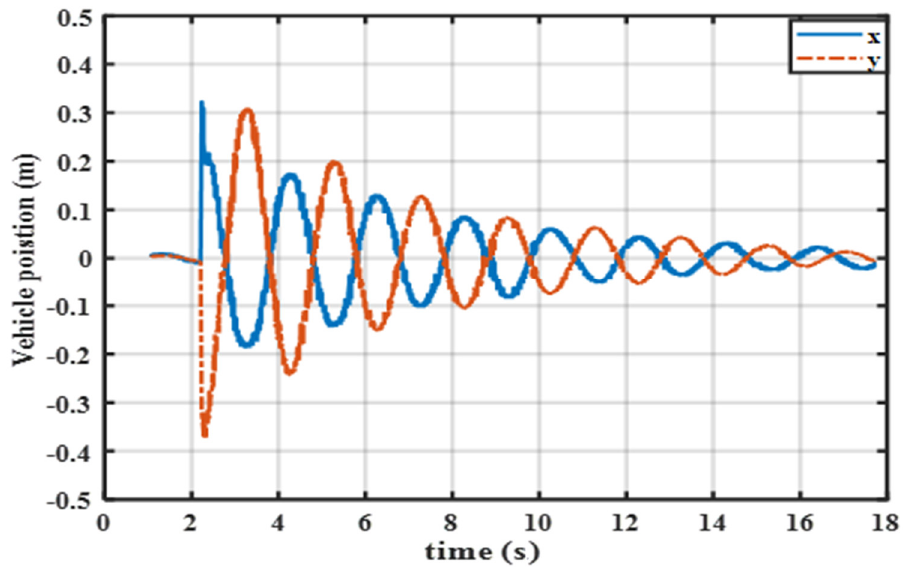
Figure 17. Time history of the quadrotor position during hover without the ASC.